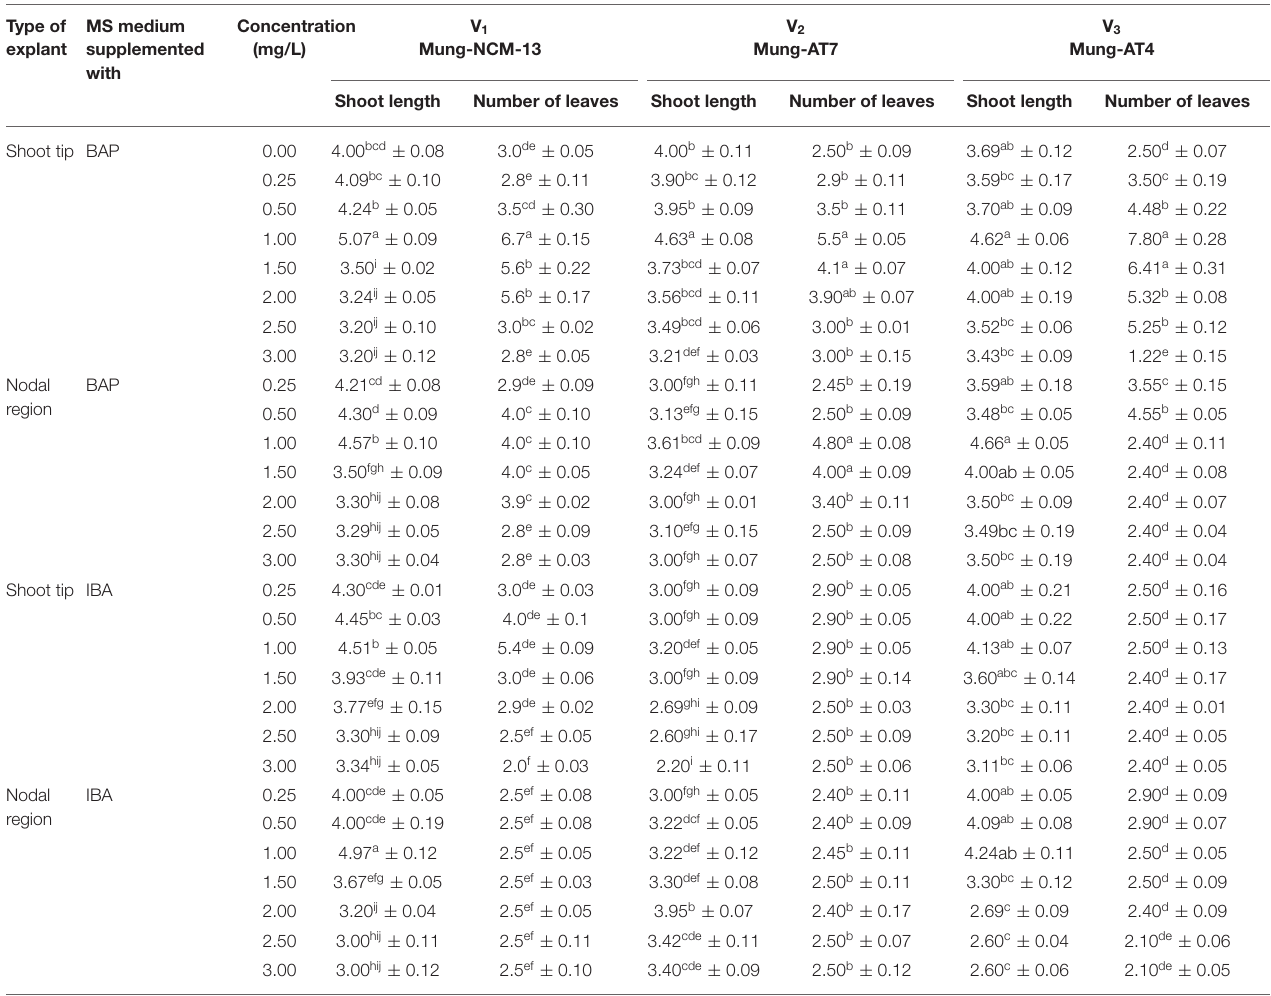
TABLE 1 | Effect of various media compositions on in vitro culture establishment of three varieties of Vigna radiate . Type of MS medium explant supplemented